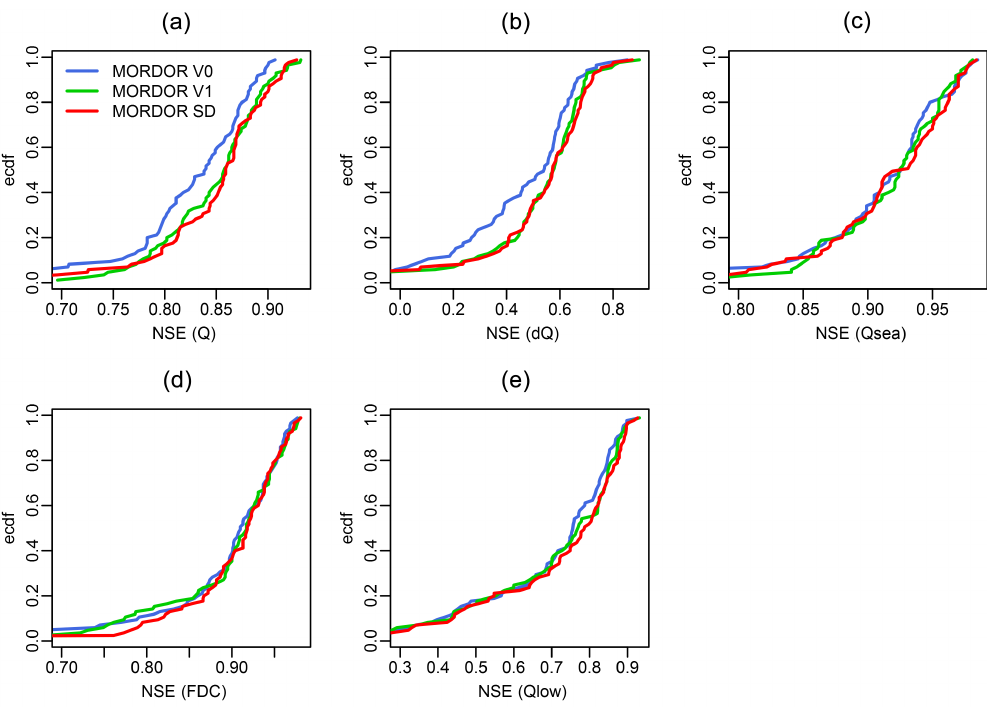
Figure 3. Performance of the three versions of the model on the validation periods, for five streamflows signatures: (a) Q , (b) d Q , (c) Q sea , (d) FDC and (e) Q low .